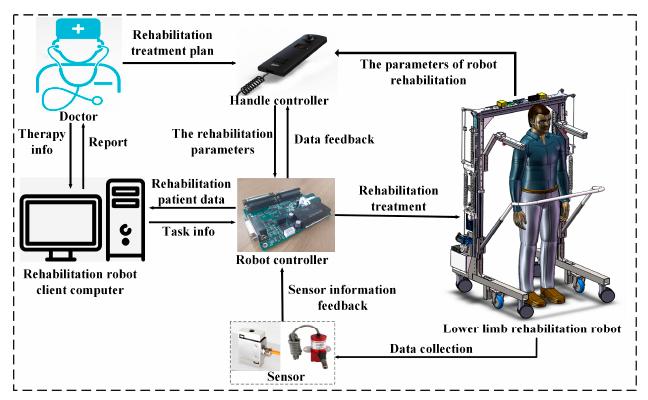
Figure 5. Control system for rehabilitation robot.